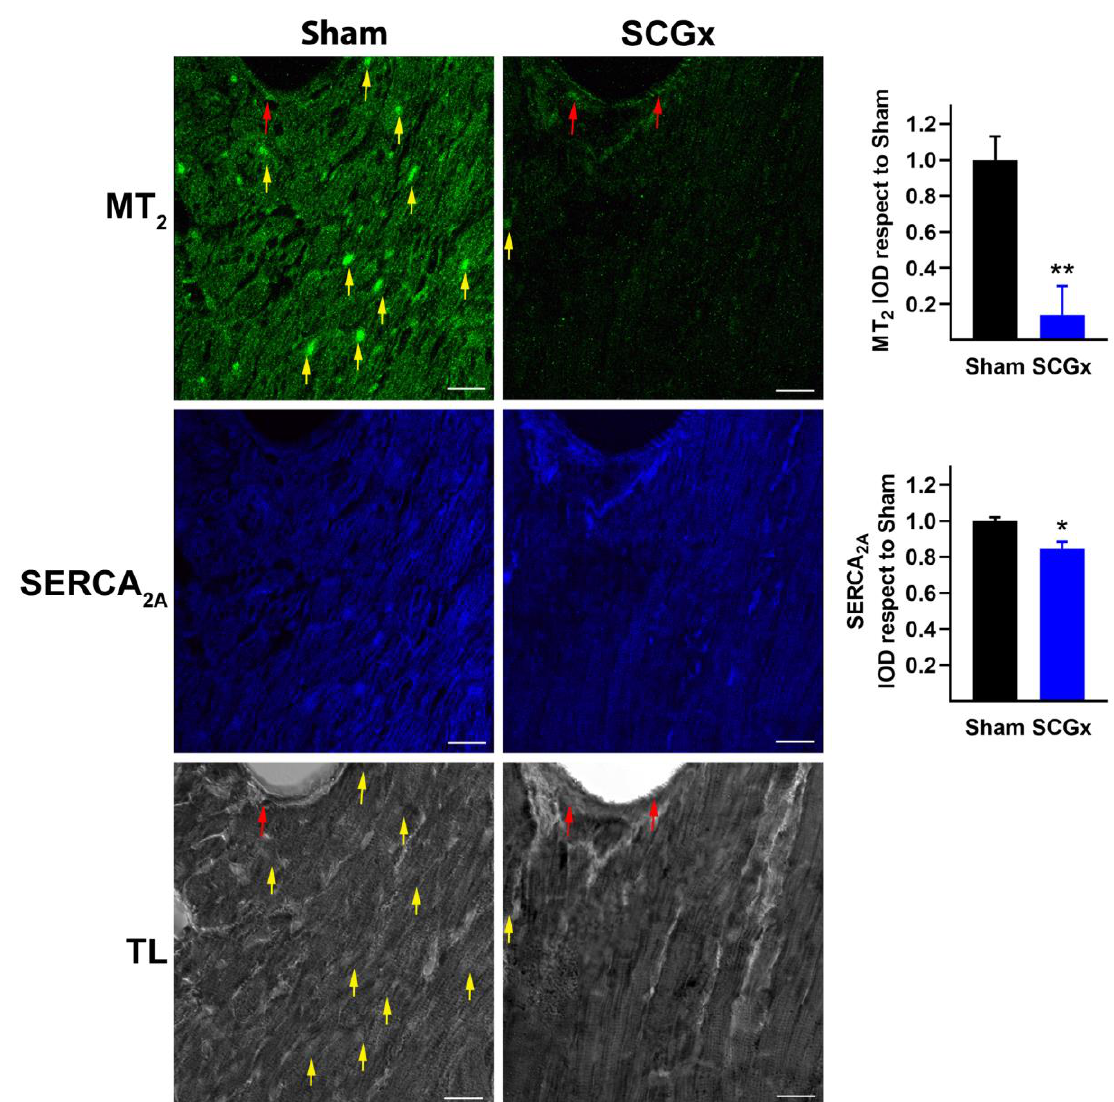
Figure 5. Melatonin receptor type 2 (MT 2 ) and SERCA 2A in myocardial tissue. The cardioprotective MT 2 receptors decreased in myocytes from the SCGx group (yellow arrows). MT 2 receptors persisted in vascular tissue (red arrows). The middle panel is shown to confirm the reduction of SERCA 2A in the SCGx hearts. Transmitted light (TL) images revealed the vascular and myocytic location of MT 2 receptors. Bars in the right-hand column indicate the mean integrated optical density (IOD) and SEM values relative to the level measured in the Sham group. The white scale bars in the lower right corners indicate 20 µM. In both groups, a total of 18 pictures were analyzed, six from three different hearts. * p < 0.05 and ** p < 0.01 vs. Sham by unpaired t-test with Welch ’ s correction.